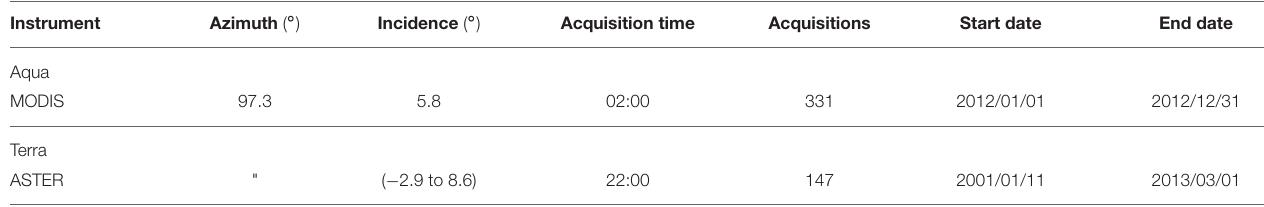
TABLE 2 | Summary of night-time thermal infrared satellite data analyzed in this study. Instrument